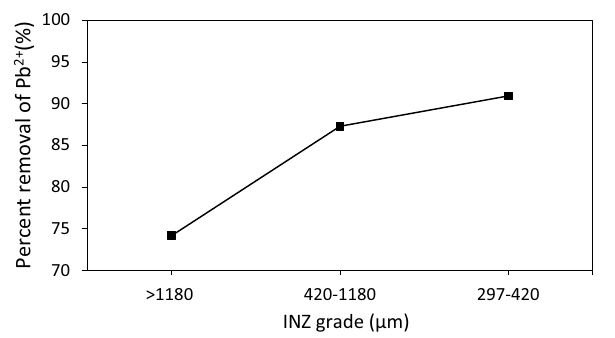
Fig. 7 Effect of particle size for Pb 2+ removal capacity of INZ (initial concentration = 50 mg/L, contact time = 120 min, pH = 4.5, adsorbent dose: INZ = 30 g/L, SR = 10